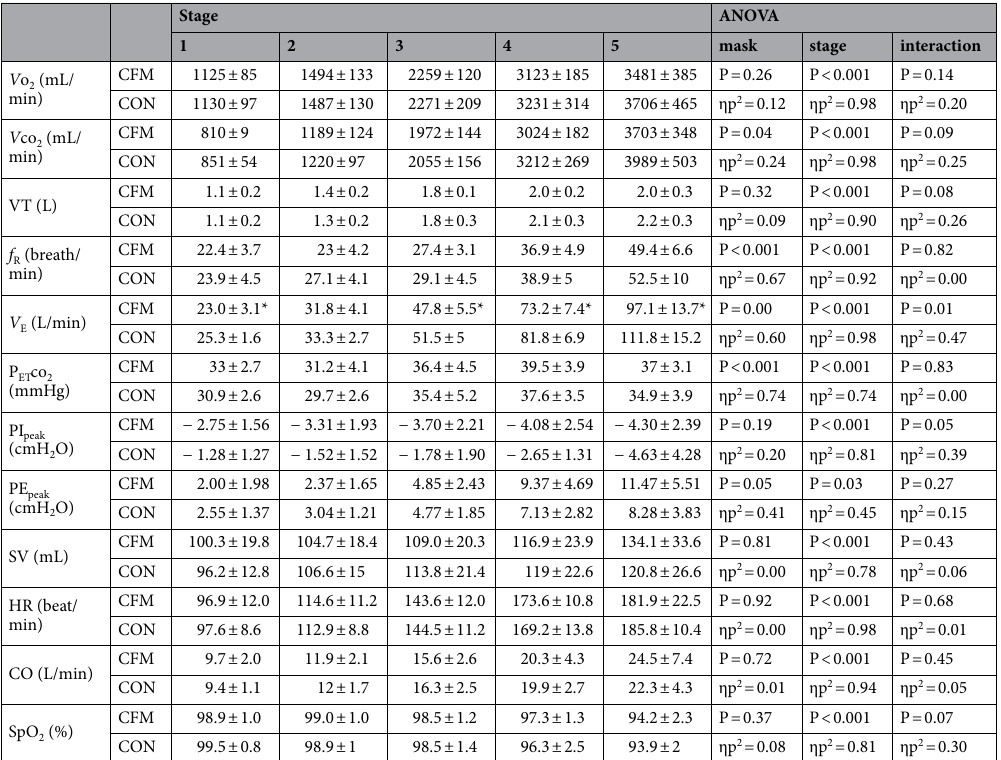
Table 3. Variables for submaximal intensity. CFM, cloth face masked trial; CON, unmasked control trial; V o 2 , oxygen uptake; V co 2 , carbon dioxide elimination; VT, tidal volume; f R , respiratory frequency; V E , minute ventilation; P ETco2 , end-tidal partial pressure of CO 2 ; PI peak , peak inspiratory mouth pressure; PE peak , peak expiratory mouth pressure; SV, stroke volume; HR, heart rate; CO, cardiac output; ∫Pm, the integral absolute value of mouth pressure; SaO 2 , arterial oxy-hemoglobin saturation. Values are expressed as the mean ± SD. *, P < 0.05, significantly different to the CON